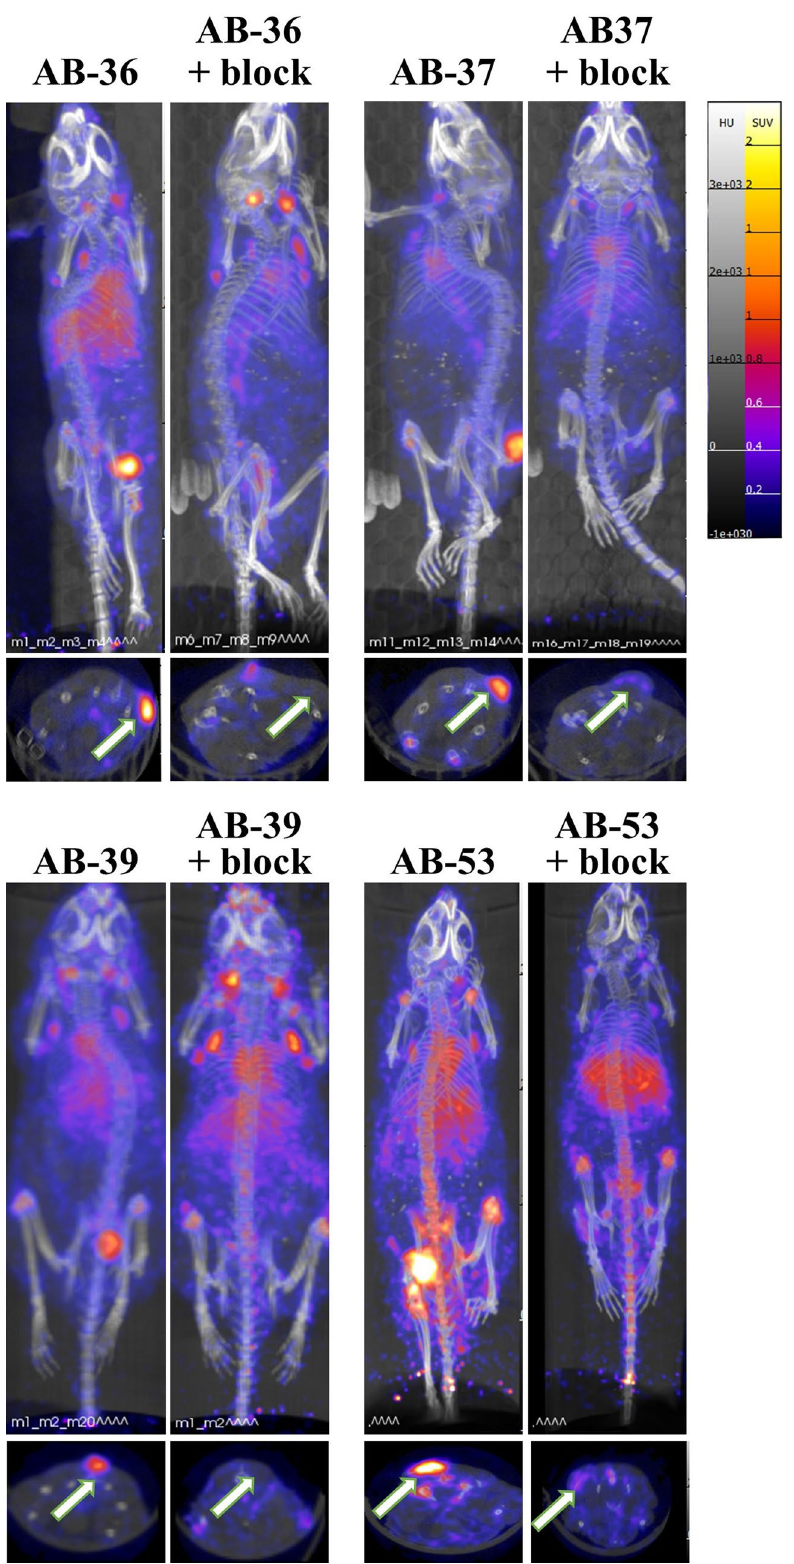
Figure 3. In vivo PET/CT imaging of ameloblastoma tumors. Representative MicroPET/CT images were obtained 7 days post injection. All animal received 89 Zr-panitumumab. The blocking group (+ block) also received an unlabeled dose of panitumumab. Tumors were implanted in the flanks of mice. Maximum intensity is demonstrated in the upper panels, and the axial slice at the center of the tumor is shown in the bottom panels (as indicated by arrow). The scale, expressed as standardized uptake value (SUV), is at the far